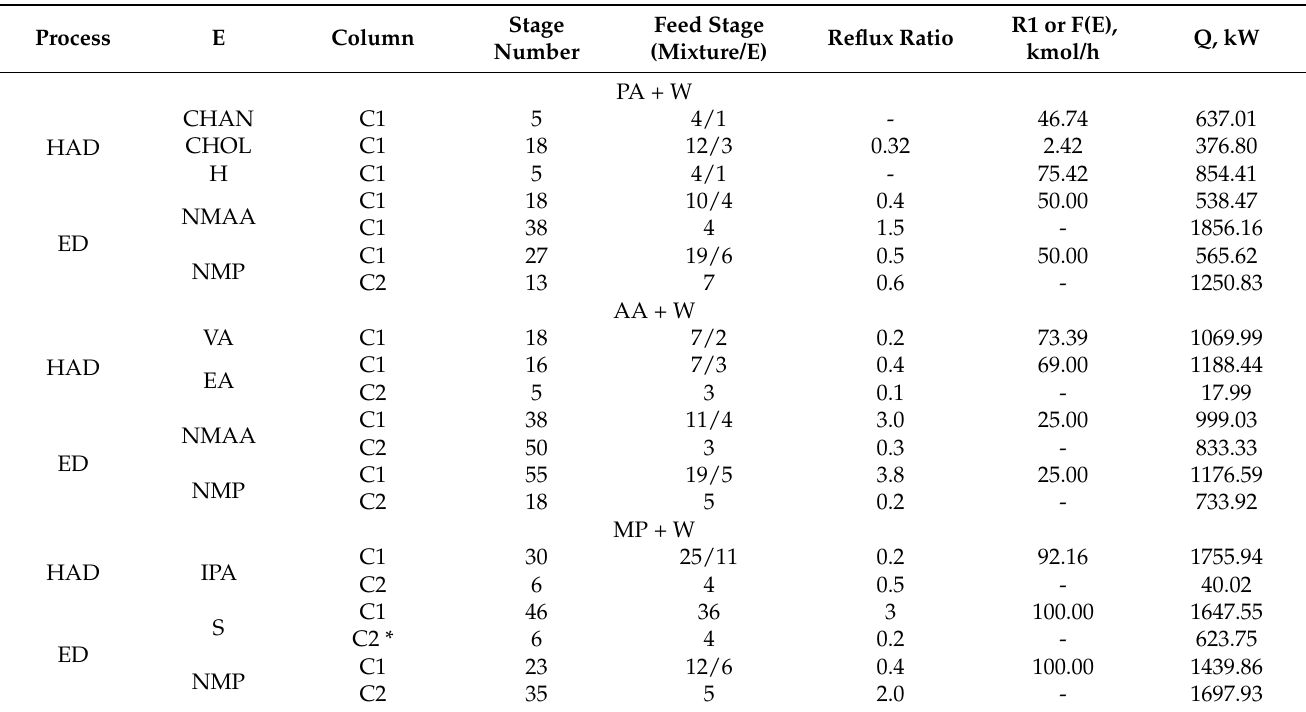
Table 4. The columns operation parameters.